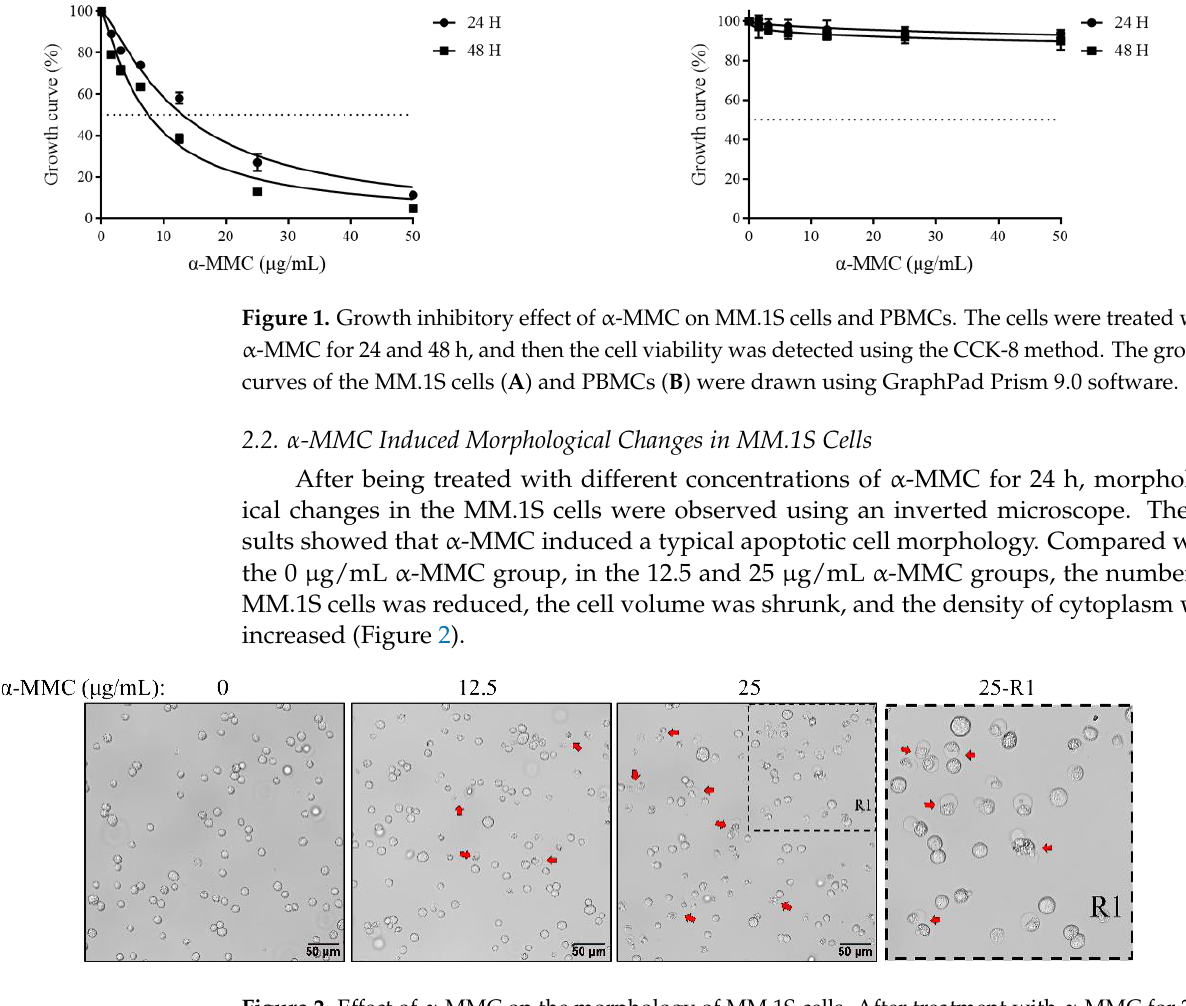
Figure 2. Effect of α -MMC on the morphology of MM.1S cells. After treatment with α -MMC for 24 h, the morphological changes in the MM.1S cells were observed under an inverted microscope. Scale bar 50 μm (20× magnification). The red arrows indicate cells with apoptotic changes in morphology.